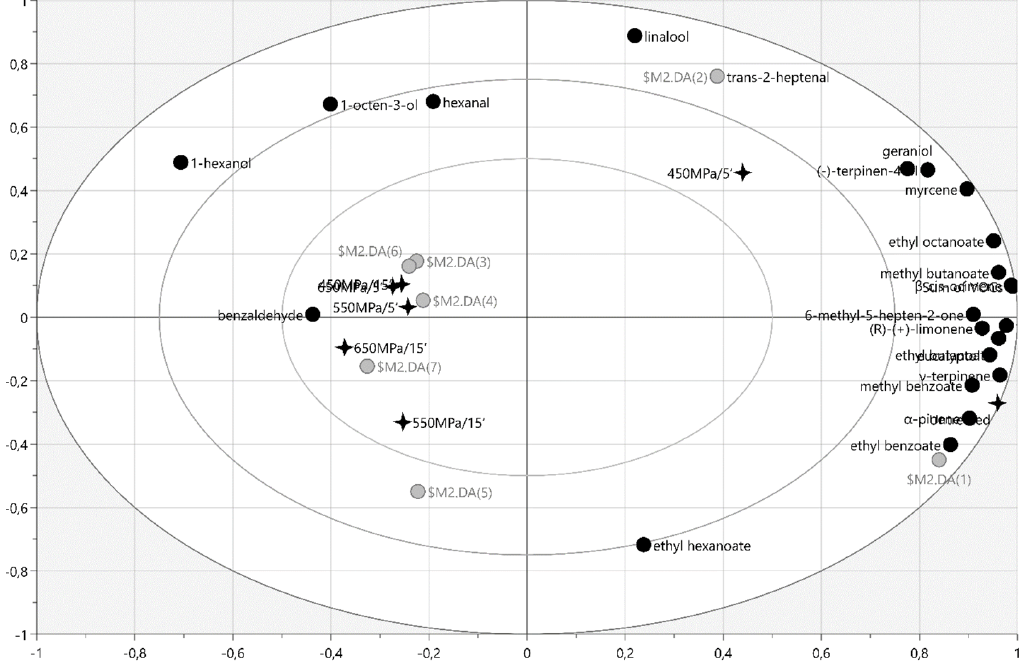
Figure 4. The bi-plot of PLS-DA for VOCs identified in the untreated and HHP-treated (450–550– 650 MPa/5 and 15 min) cv Weiki.